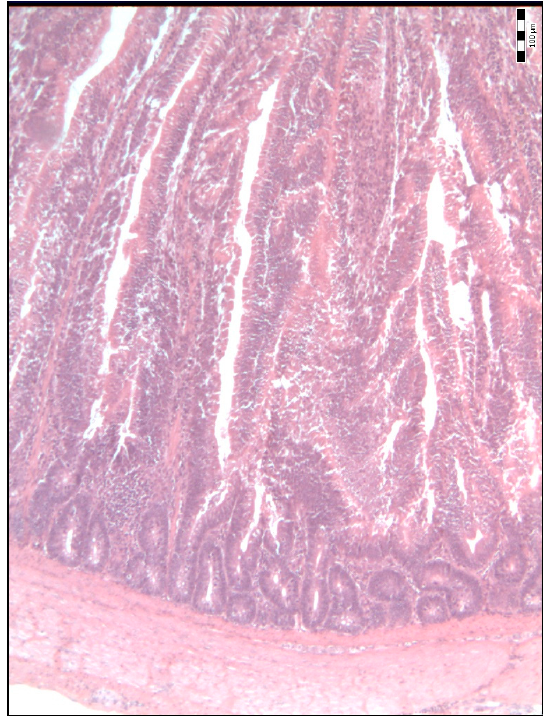
Figure 2. Histological representation of the duodenal villi of broiler chickens from the P1 experimental group of chickens (H&E; ×100).